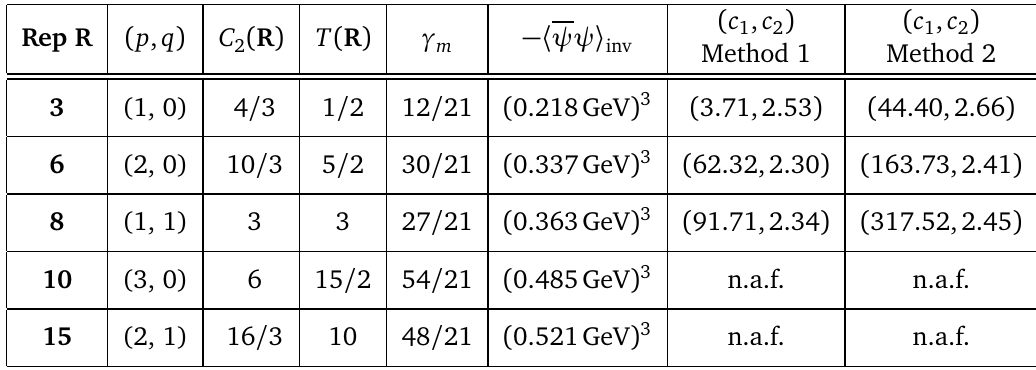
Table 1: Summary of our results for the chiral and vector-like condensates for quarks in different representations of QCD. We show Dynkin labels ( p , q ) , quadratic Casimir ( R ) and Dynkin indices T ( R ) of the representations, as well as the cor- invariants C 2 responding mass anomalous dimensions γ . The renormalization group invariant m chiral condensates 〈 ψψ 〉 are obtained from Eq. (5). The last two columns describe inv m µ the VL quark condensates 〈 ψψ 〉 as a function of the current quark mass m µ in the inv limit m µ ≫ Λ , in terms of the fit values c and c of the general empirical relation QCD 1 2 Eq. (16) for two different extraction methods (see text). The full solution for a VL quark in the triplet representation is shown in Fig. 4. We do not include representa- tions larger than the 8 here, as the strong interaction then turns non asymptotically free (n.a.f.).